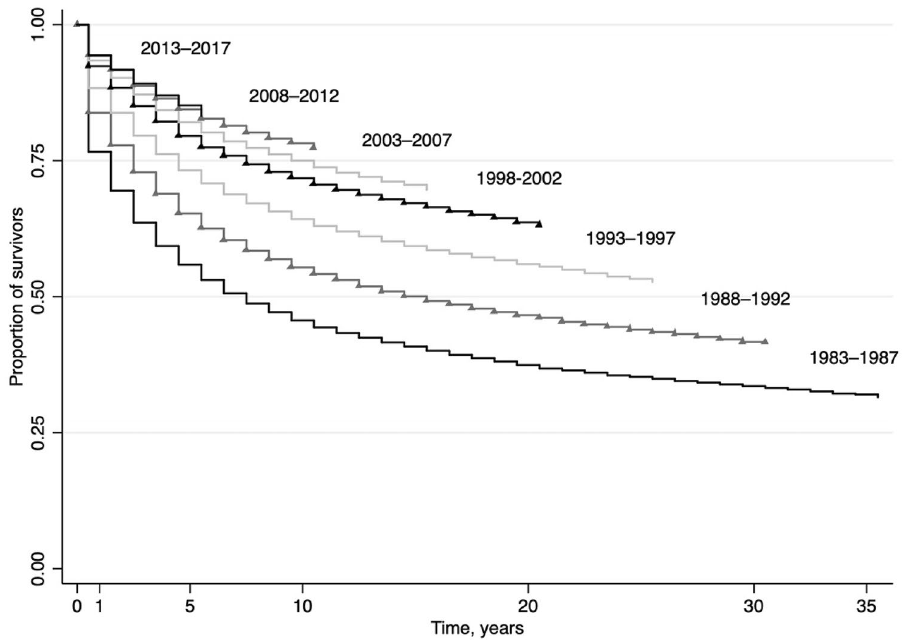
Figure 2. Kaplan–Meier estimates for breast-cancer specific survival in female patients in Austria according to period of diagnosis (five-year groups),